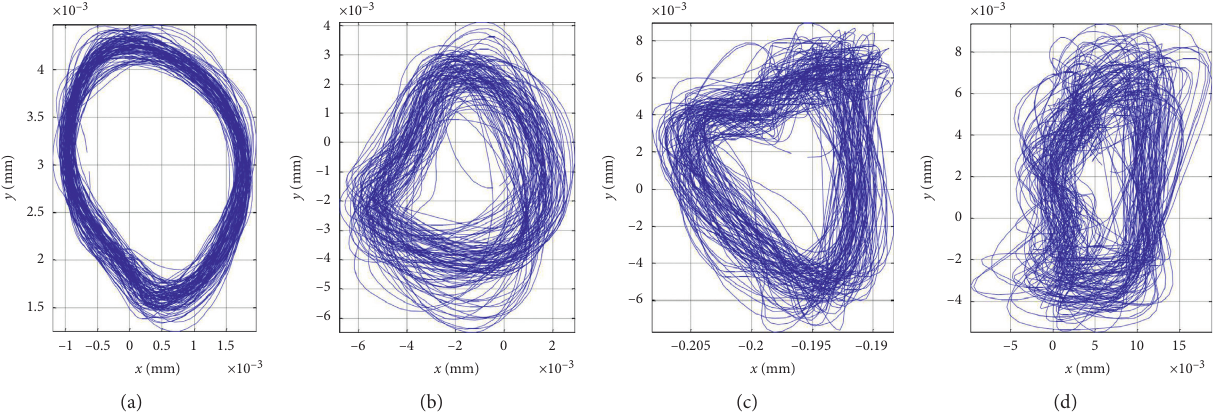
Figure 9: Axis orbits of the spindle at 5000r/min. (a) Condition 1. (b) Condition 2. (c) Condition 3. (d) Condition